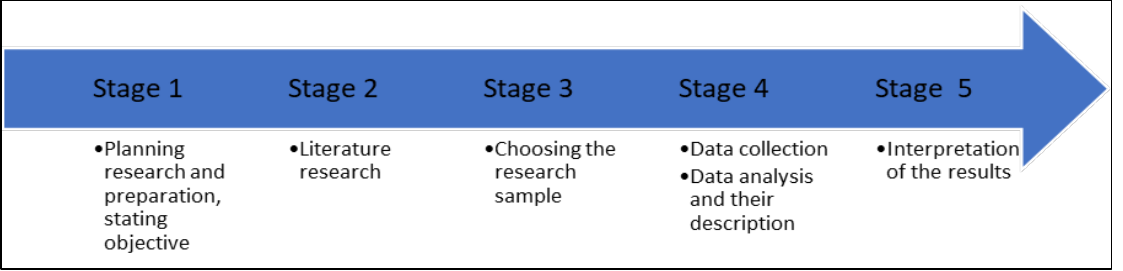
Figure 4. Research